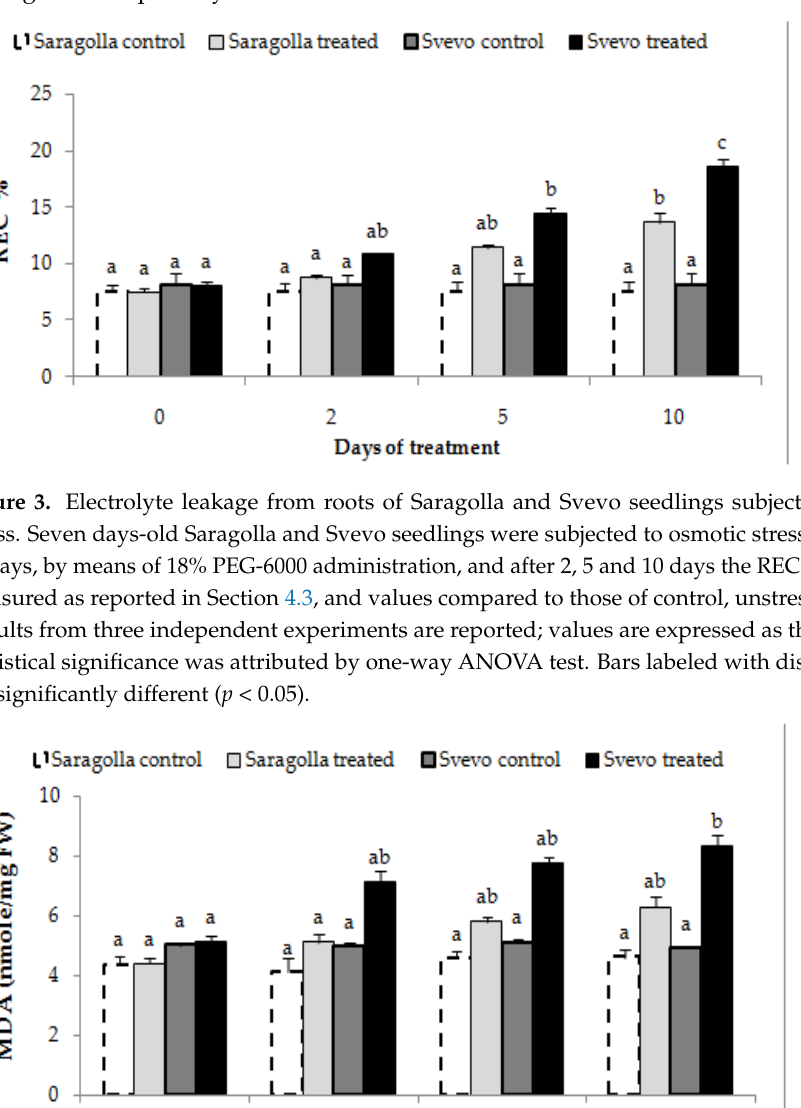
Figure 3. Electrolyte leakage from roots of Saragolla and Svevo seedlings subjected to osmotic stress. Seven days-old Saragolla and Svevo seedlings were subjected to osmotic stress treatment for 10 days, by means of 18% PEG-6000 administration, and after 2, 5 and 10 days the REC% of roots was measured as reported in Section 4.3, and values compared to those of control, unstressed seedlings. Results from three independent experiments are reported; values are expressed as the mean ± SD. Statistical significance was attributed by one-way ANOVA test. Bars labeled with dis- similar letters are significantly different ( p < 0.05).